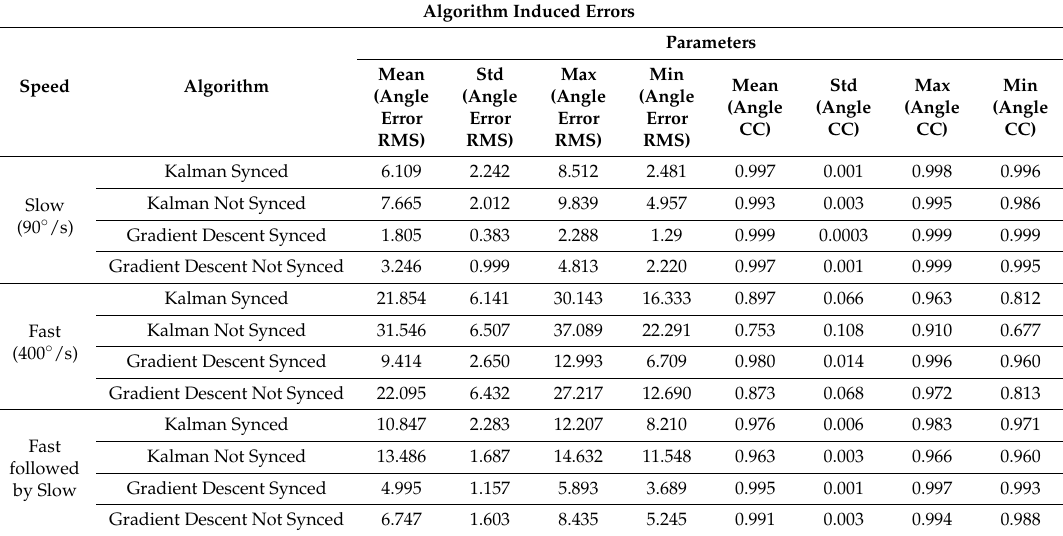
Table 2. RMS (in ◦ ) and Correlation Coefficient (CC) between knee angles estimated using different algorithms Vs universal